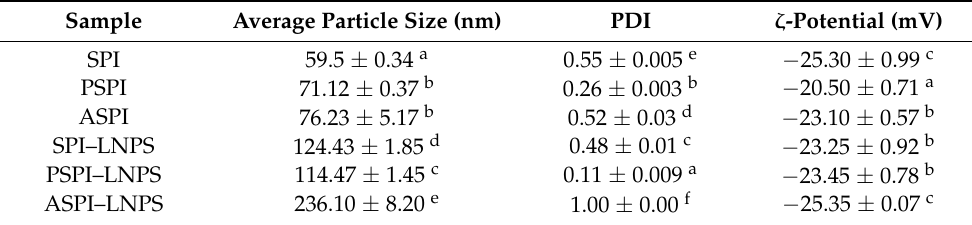
Table 2. Average particle size, PDI, and ζ -potential of SPI, PSPI, and ASPI and their lutein-loaded nanoparticles.